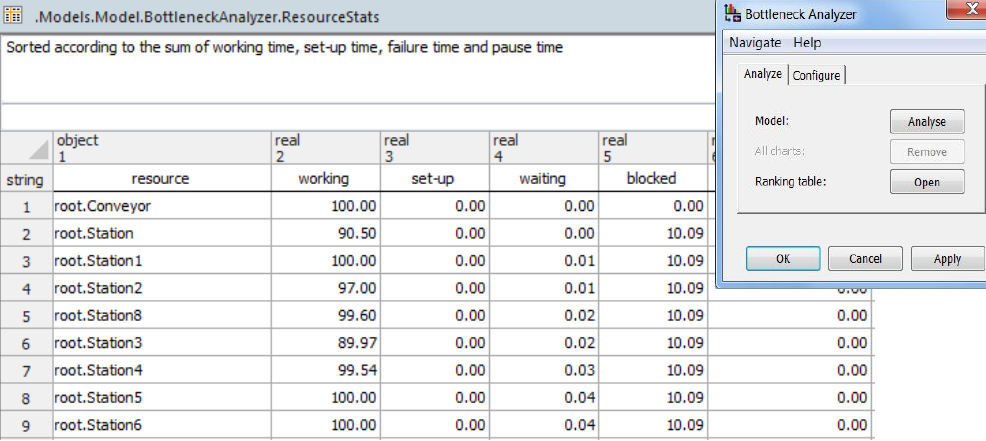
Figure 10. Bottleneck Analyzer after optimization.